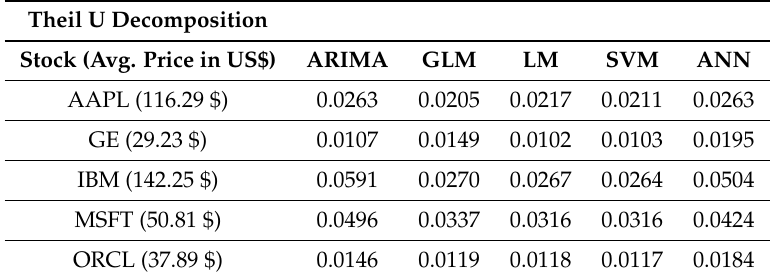
Table 3. Theil’s U 2 decomposition results for the different algorithms and